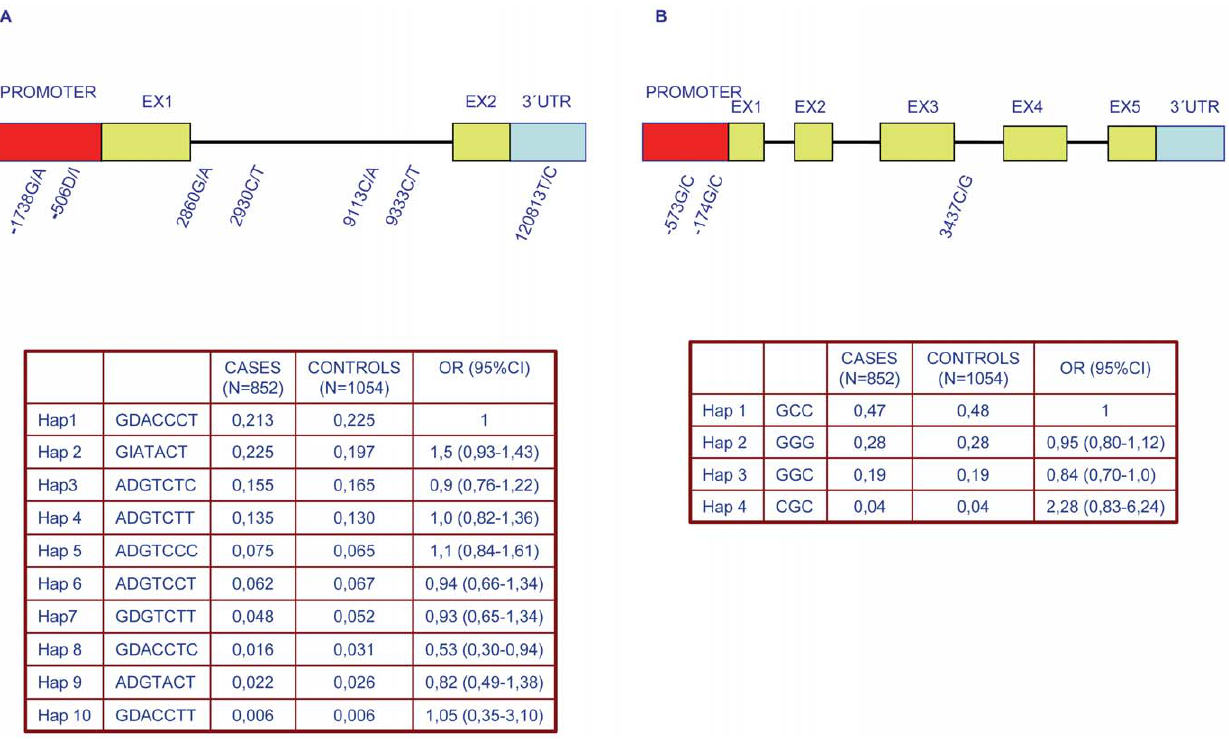
Figure 1. F2R and IL6 genes: tag SNPs and haplotype frequencies. Top panel. Schematic representation of F2R (Panel A) and IL6 (Panel B) tagSNPs mapping position. Ex: exon, 3 9 UTR: 3 9 untranslated region. Bottom panel. Table illustrating F2R (Panel A) and IL6 (Panel B) haplotype frequency in SHEEP male cases and controls. The table reported in panel A has been modified from Gigante B. et al, Thromb Haemost . 2009;101(5):943–953 (permission to reprint obtained from the publisher).